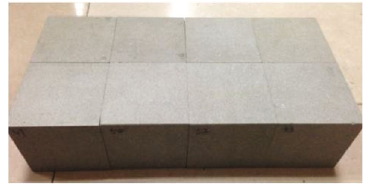
Figure 1: Photograph of some sandstone samples.